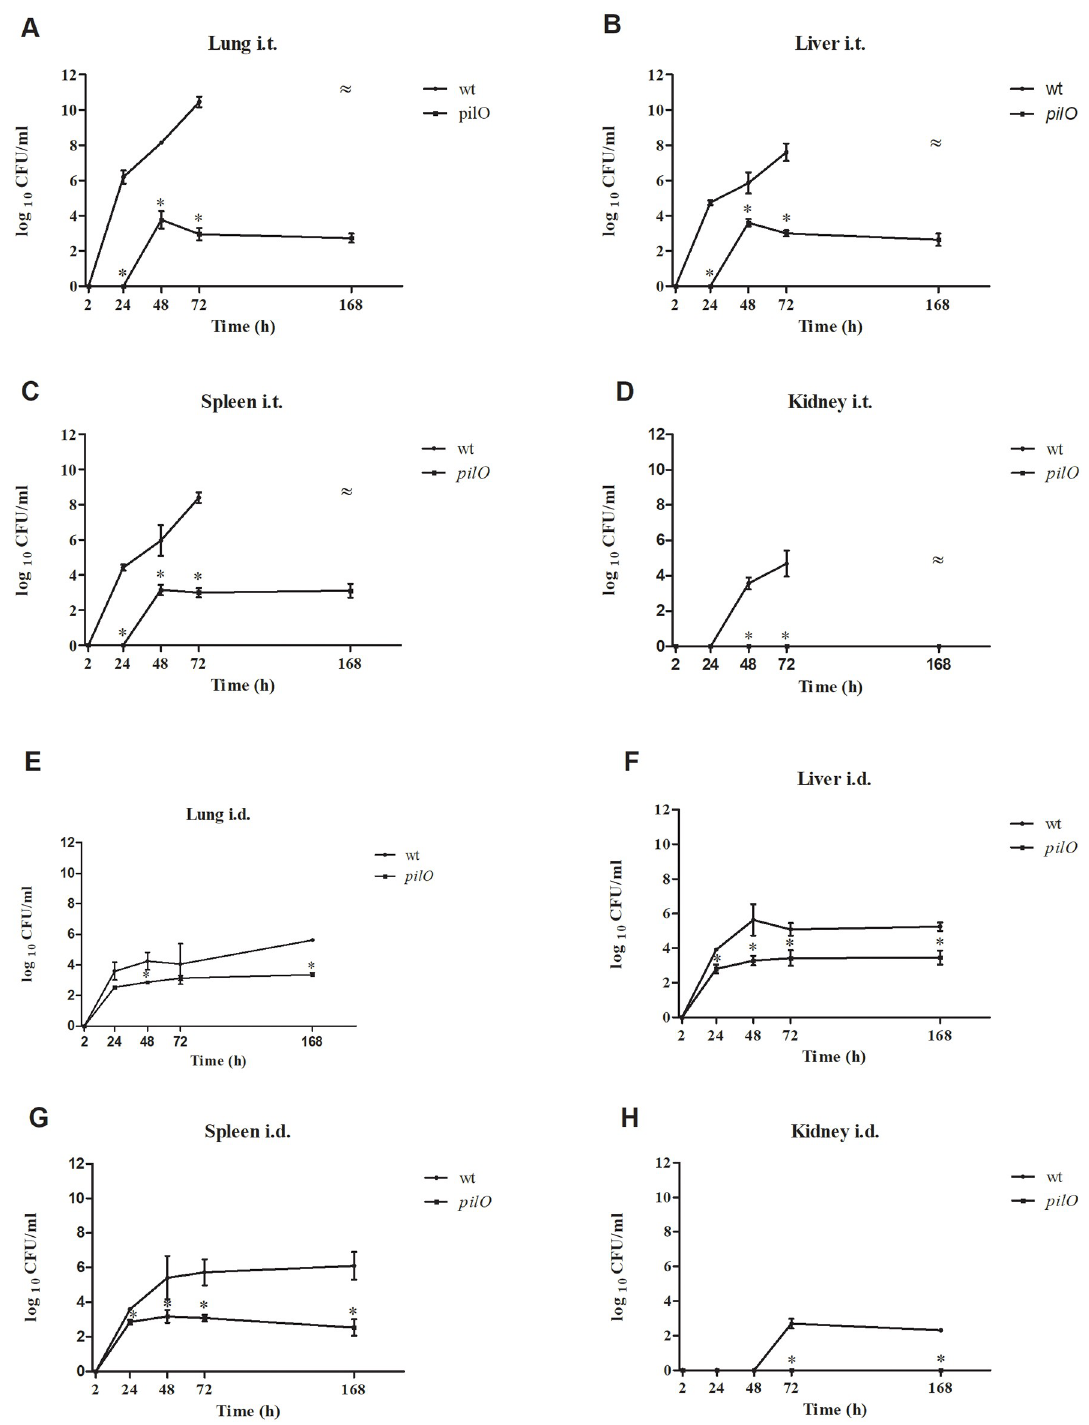
Fig 8. Growth kinetics of F . novicida within the organs of infected BALB/c mice. Groups of three mice were infected intratracheally (i.t.) with 10 bacteria per mouse using wt F . novicida or the pilO mutant strain. Bacterial burden was determined in lung (A) , liver (B) , spleen (C) and kidney (D) at 2 h, 24 h, 48 h, 72 h, and 7 days after infection. Other groups of three mice were infected intradermally (i. d.) with 10 4 bacteria per mouse, using the identical strains and time points, upon which the bacterial burden was determined in lung (E) , liver (F) , spleen (G) and kidney (H) . The error bars represent standard deviations of triplicate samples. � Bacterial burdens for mice infected with the wt F . novicida were not determined at 7 days after i.t. infection because the mice did not survive until that time point. Asterisks denote that the growth kinetics is statistically different from that of wt F . novicida , as determined by Student t- test ( � , p < 0.05).